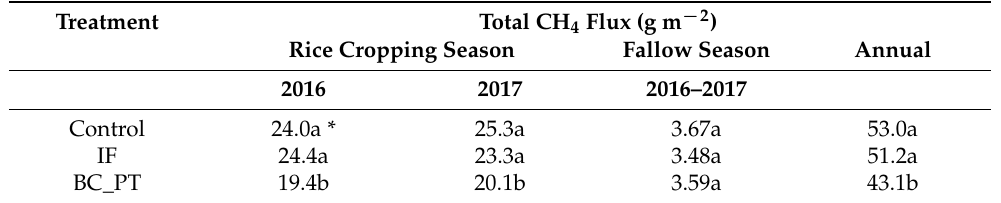
Figure 3. Changes in CH 4 emission rates during rice cropping and fallow seasons. Error bars represent standard deviations ( n = 3). Table 4. Total CH 4 flux during rice cropping, fallow, and